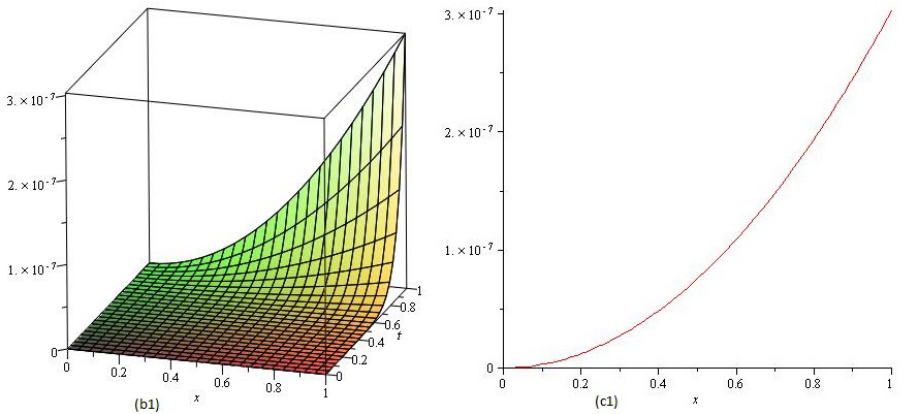
Figure 4. The error plot of Example 2, at γ = 1 and t =